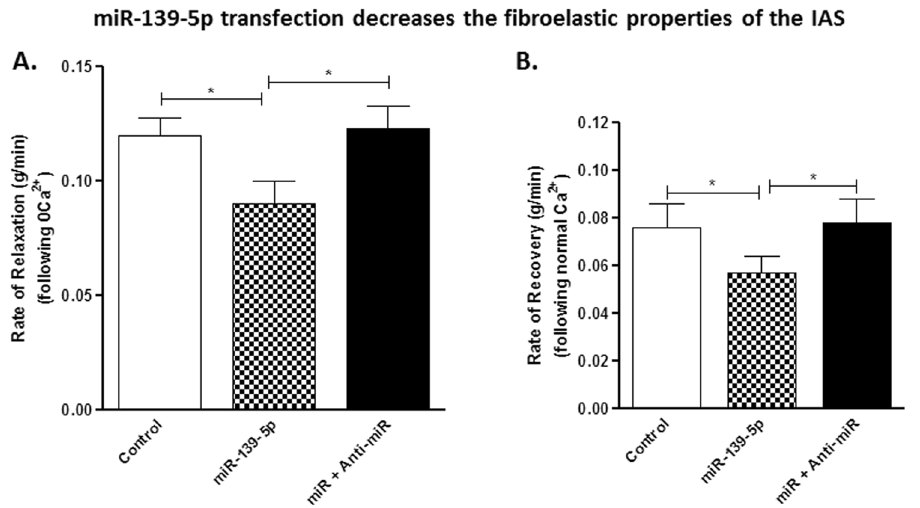
Figure 6. Effect of miRNA- and anti-miRNA-139-5p on IAS kinetics. ( A,B ) Graphs showing rate of relaxation ( A ) and of recovery ( B ) of IAS tone following 0 Ca 2 + and normal Ca 2 + replenishment, respectively, following transfection of the smooth muscle strips. miRNA-139-5p significantly ( * p < 0.05) decreases the rates of relaxation and of recovery of the IAS tone which are significantly reversed by anti-miRNA-139-5p pre- treatment ( * p < 0.05; n =